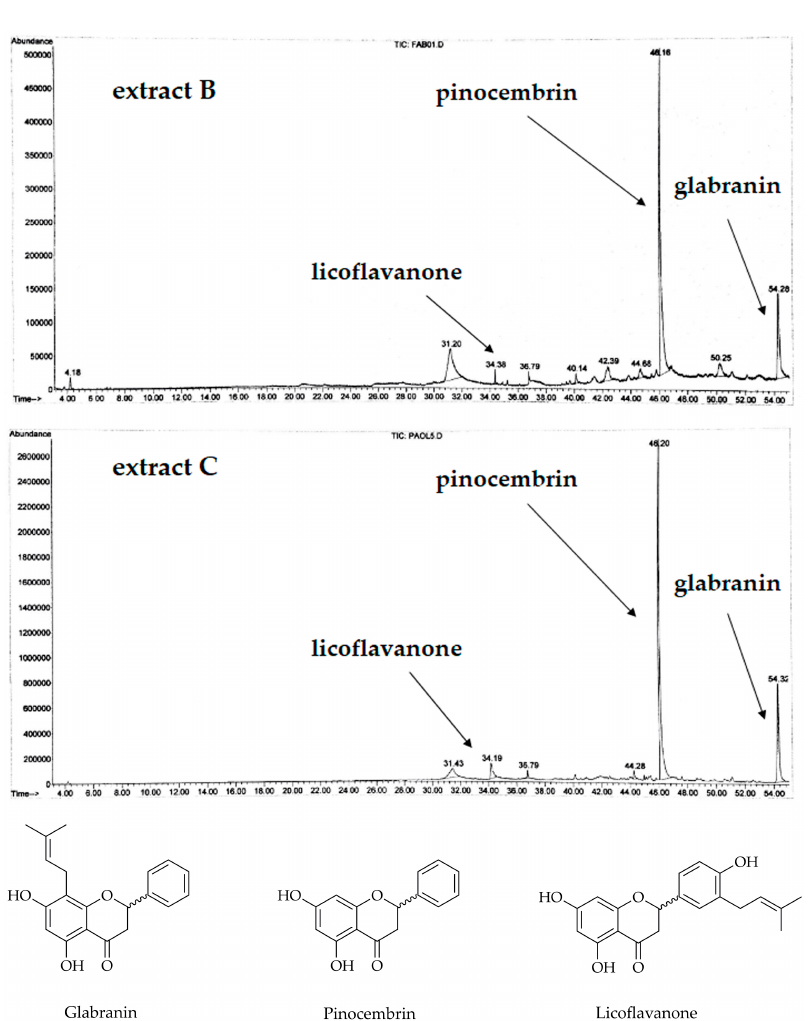
Figure 2. Gas chromatography / mass spectrometry (GC-MS) chromatograms of the phytocomplexes from Glycyrrhiza glabra L. leaves and chemical structure of isolated compounds.